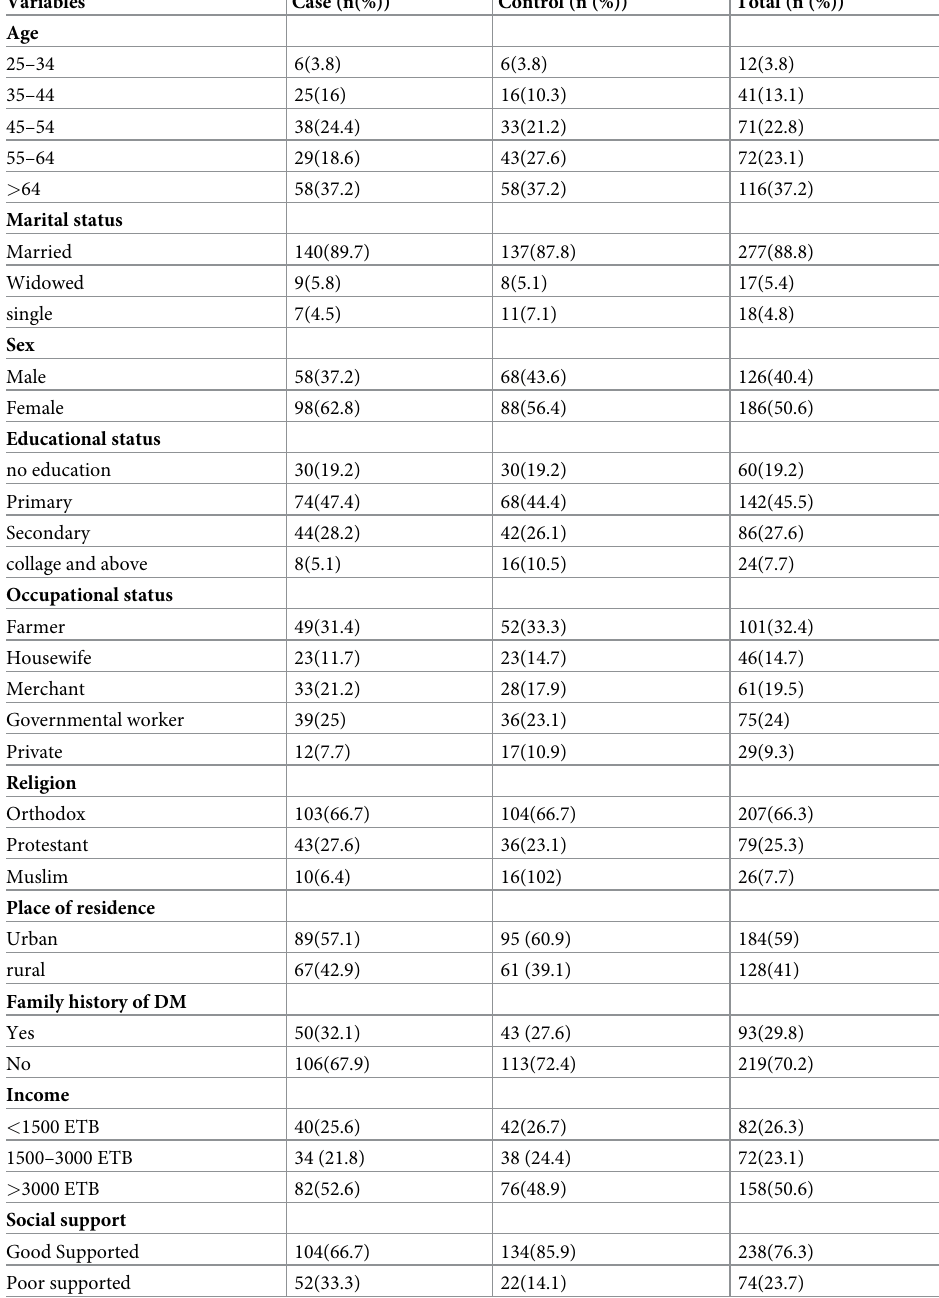
Table 1. Socio-demographic characteristics of diabetic patients under follow-up in clinics at Gamo and Gofa zones, southern, Ethiopia, 2021.